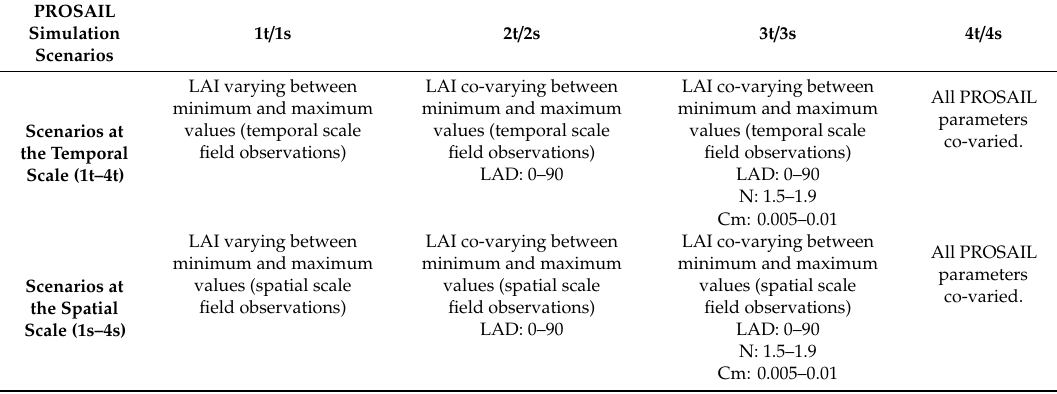
Table 4. Di ff erent scenarios analyzed with the PROSAIL simulation at the temporal (1t–4t) and spatial (1s–4s)